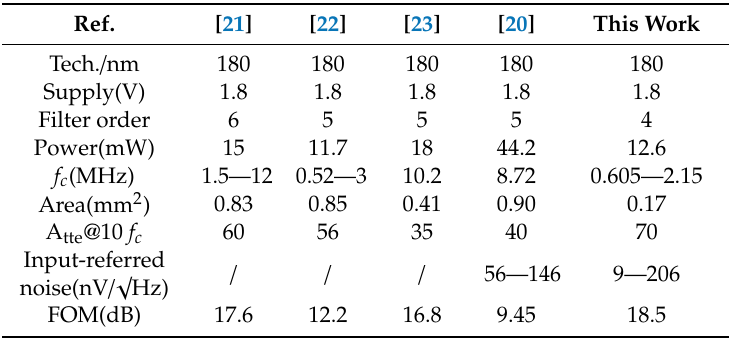
Table 1. Performance summary and comparison with other prior